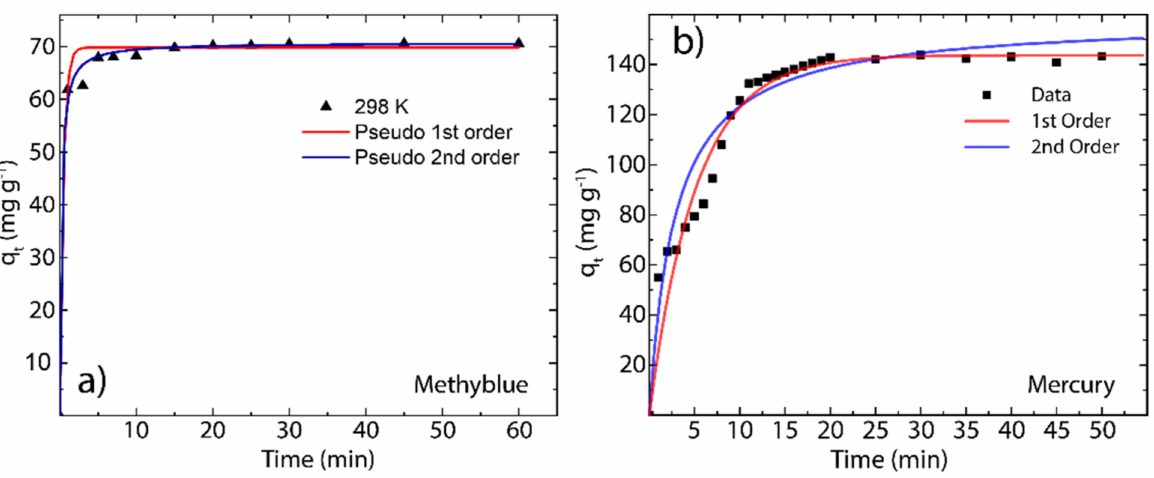
Figure 5. Adsorption kinetics of ( a ) MB on rGO and ( b ) Hg(II) on rGO as a function of contact time (60 min) at 298